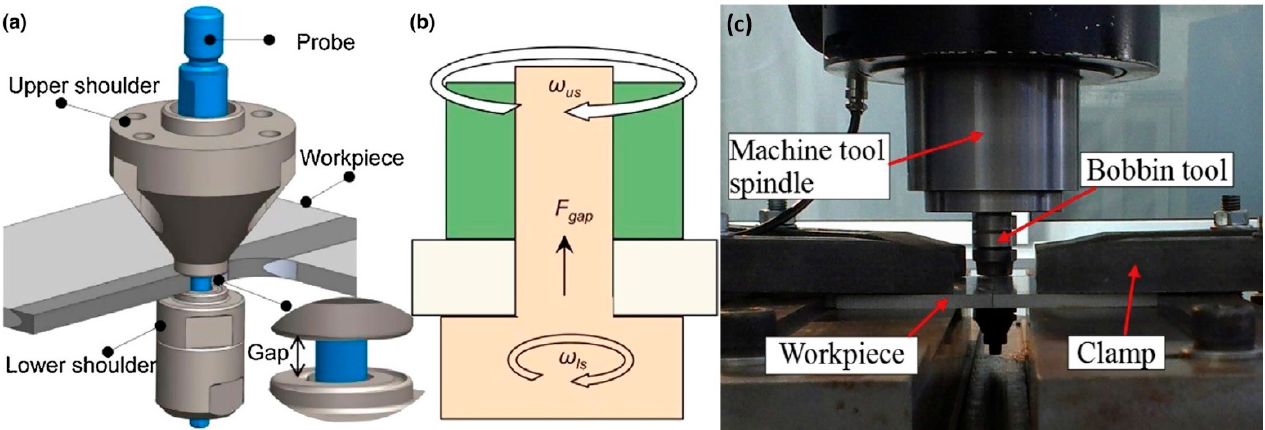
Figure 25. ( a ) Details of the bobbin welding tool and ( b ) schematic of BT-FSW [191] ( c ) Experimental setup of BT-FSW process [190]. Figure 25a,b reprinted from: Improving weld formability by a novel dual-rotation bobbin tool friction stir welding. Journal of Materials Science & Technology 34, no. 1 (2018): 135–139, Wang, F. F., W. Y. Li, J. Shen, Q. Wen, and J. F. Dos Santos, Copyright 2018, with permission from Elsevier. Figure 25c reprinted from: Microstructural characteristics and mechanical properties of bobbin tool friction stir welded 2A14-T6 aluminum alloy. Materials & Design (1980–2015) 65 (2015): 559–566, Zhang, Huijie, Min Wang, Xiao Zhang, and Guangxin Yang, Copyright 2014, with permission from